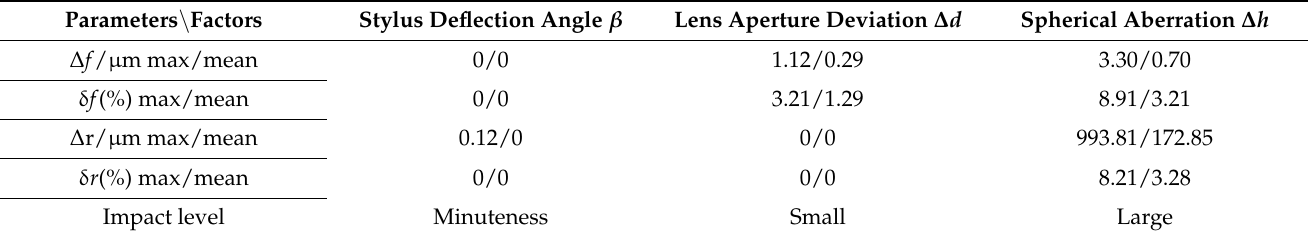
Figure 12. Sagittal height error and relative error due to caliber deviation. ( a ) Lens aperture value; ( b ) Radius of curvature of the lens with respect to the vector height. Table 3. Statistics of error values.